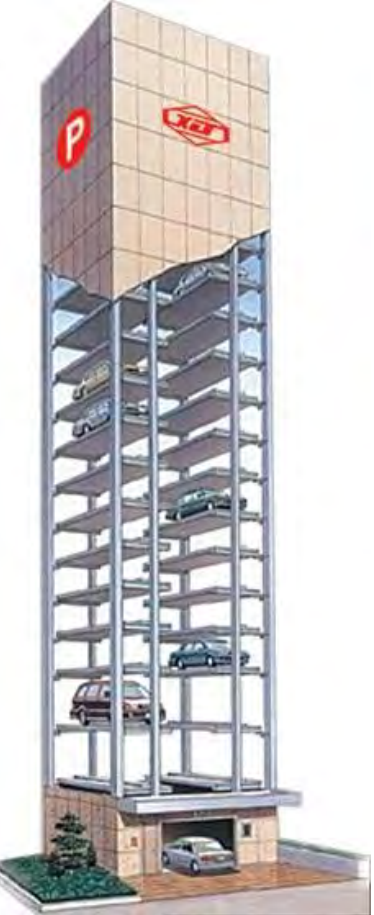
Figure 10. (APS) surface of the land. (Shanghai Shi Wen,